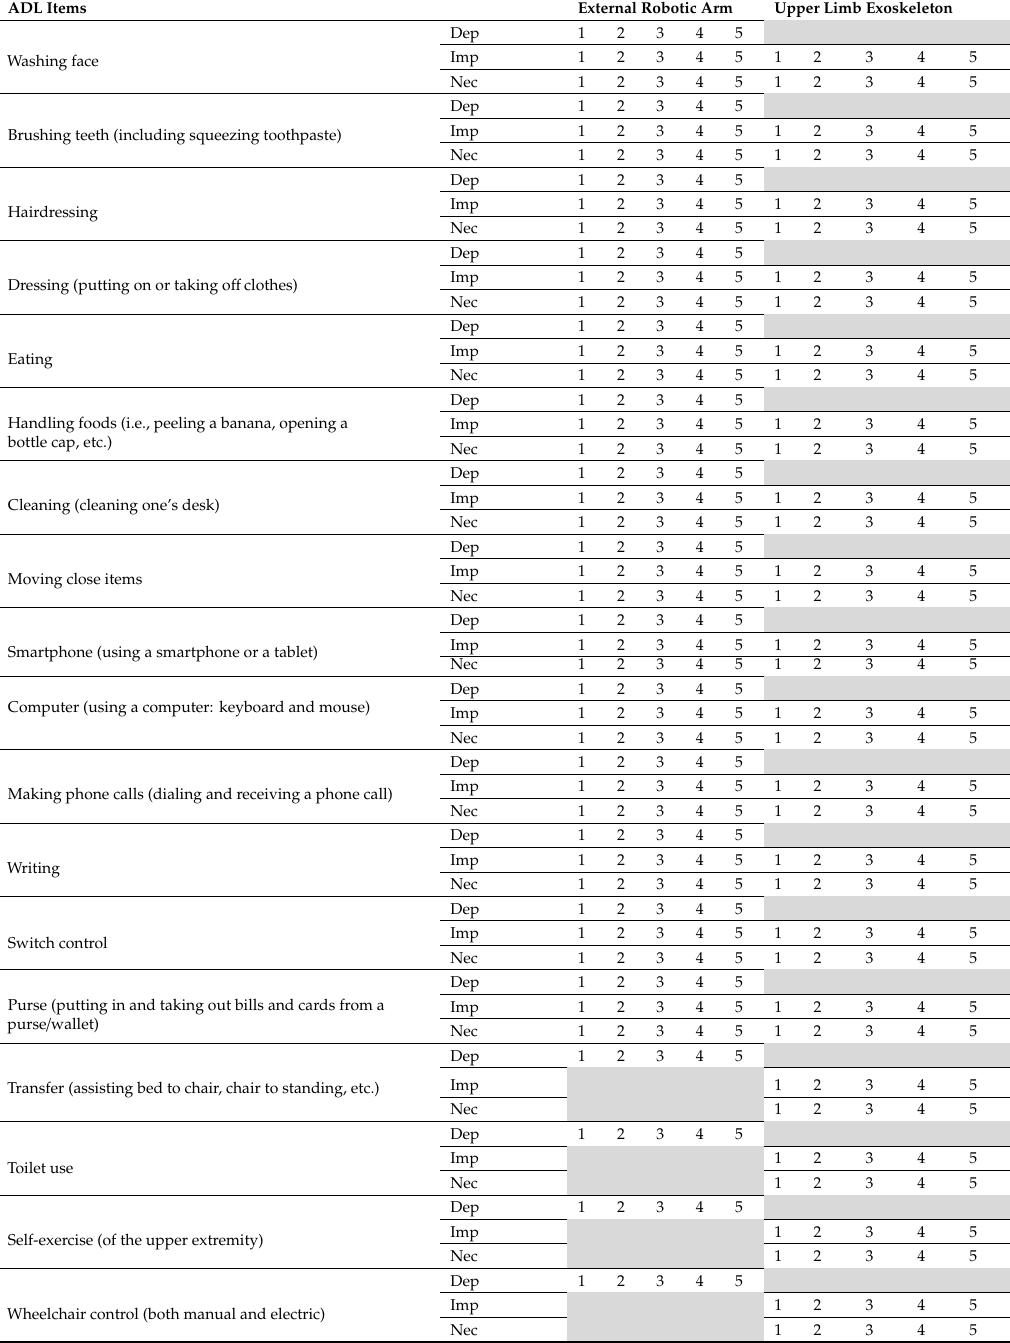
Table A2. Rating chart for each ADL